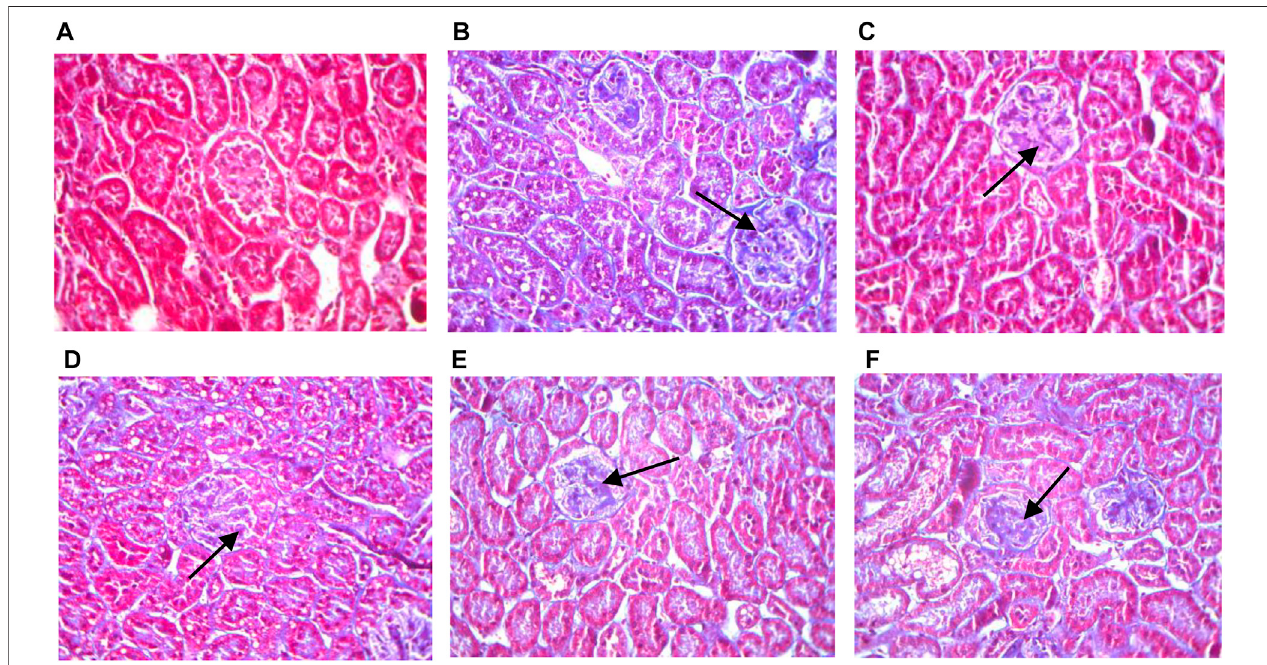
FIGURE 3 | Kidneys pathological sectioning of various groups (Masson ×400). Control group (A) ; model group (B) ; high dosage (C) ; medium dosage (D) ; low dosage (E) ; Huangqi Liuyi decoction (F) .